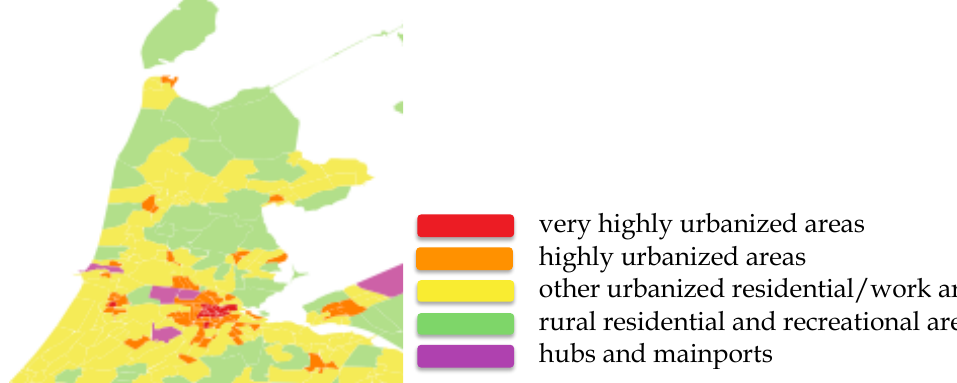
The Province of North-Holland and its region